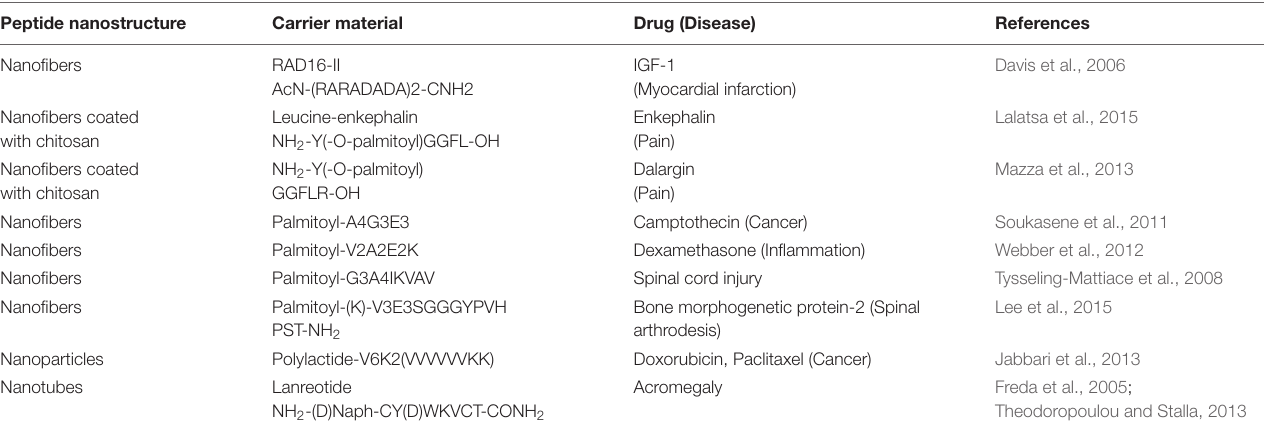
FIGURE 4 | TEM images of (a) Boc-F- (cid:49) F-Ahx-GA dipeptide, (b) FAE-loaded Boc-F- (cid:49) F-Ahx-GA dipeptide, (c) Boc-F- (cid:49) F-Ahx-Neomycin dipeptide, (d) Curcumin-loaded Boc-F- (cid:49) F-Ahx-Neomycin dipeptide, (e) Boc-P-F-G-OMe tripeptide and (f) Curcumin-loaded Boc-P-F-G-OMe tripeptide; (g) Boc-P- (cid:49) F-G-OMe tripeptide and (h) Curcumin-loaded Boc-P- (cid:49) F-G-OMe tripeptide. ( a and b: Reproduced from Reference (Mahato et al., 2012) with permission from the Royal Society of Chemistry; c and d: Reproduced from reference (Yadav et al., 2014a) with permission from the Royal Society of Chemistry; e and f: Reproduced from reference (Yadav et al., 2015) with permission from Bentham Science Publishers; g and h: Reproduced from reference (Deka et al., 2017) with permission from Elsevier. TABLE 3 | List of peptide-based self-assembled nanostructures for drug delivery